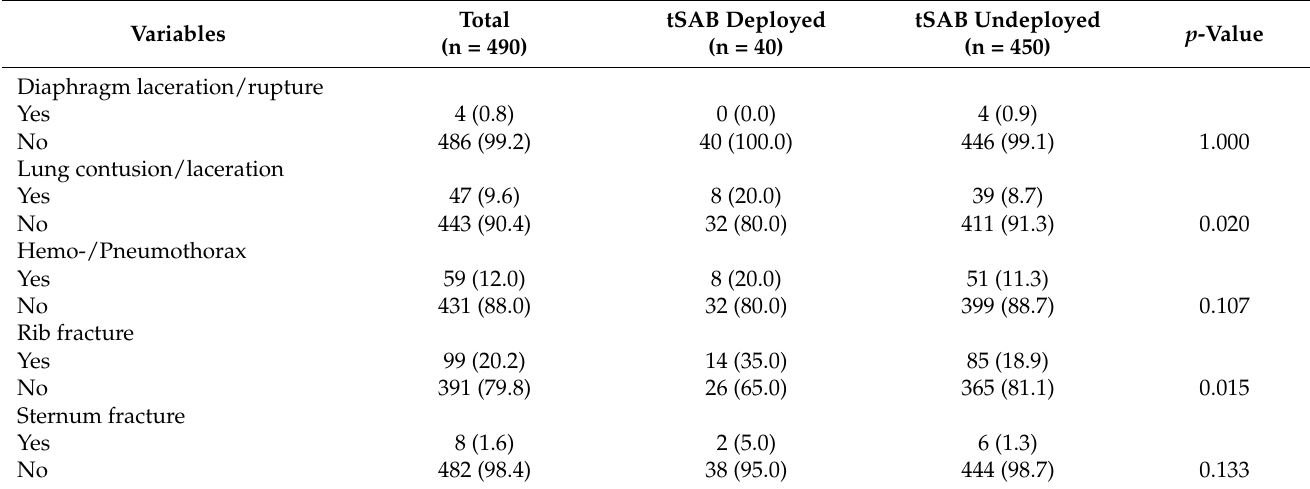
Table 3. Thoracic injury distribution according to tSAB deployment in side impacts.